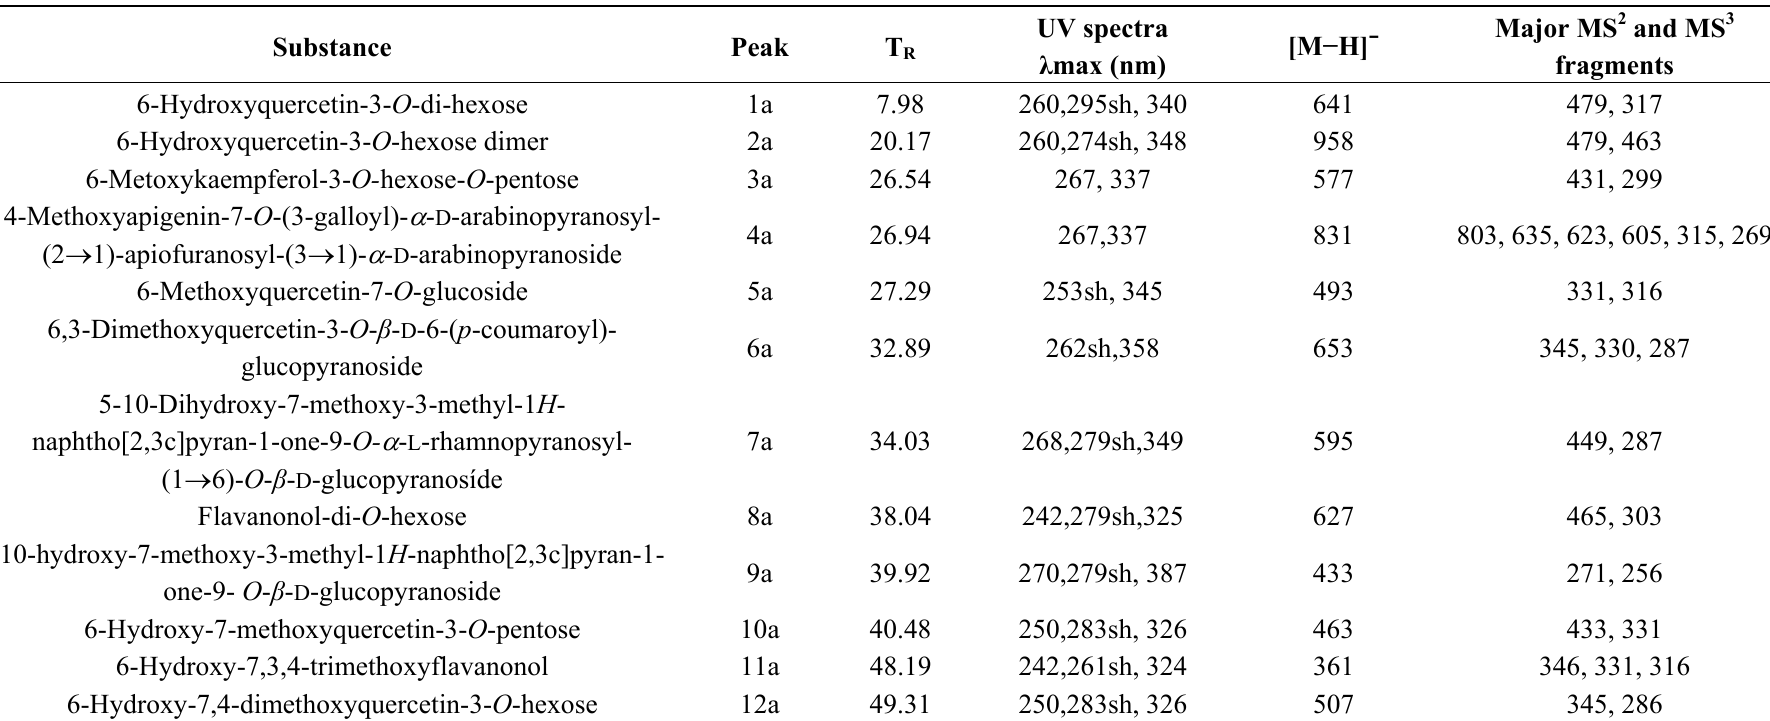
Table 2. ESI-MS and ESI-MS n product ions of compounds occurring in the methanol extracts of scapes from P. chiquitensis